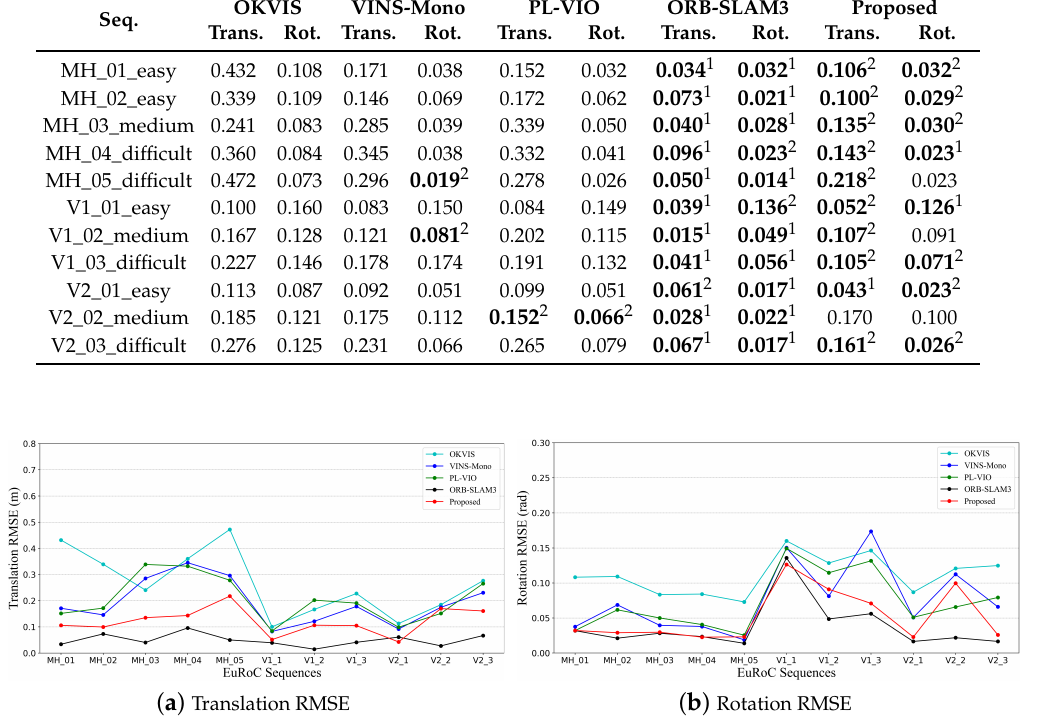
Figure 6. The comparison of root mean square error (RMSE) of translation and rotation in the EuRoC